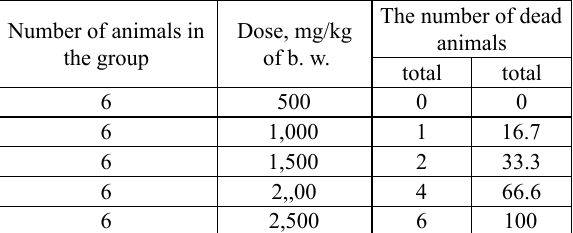
Fig. 4. Crystal structure of the Acute toxicity compounds by intramuscular administration to white rats